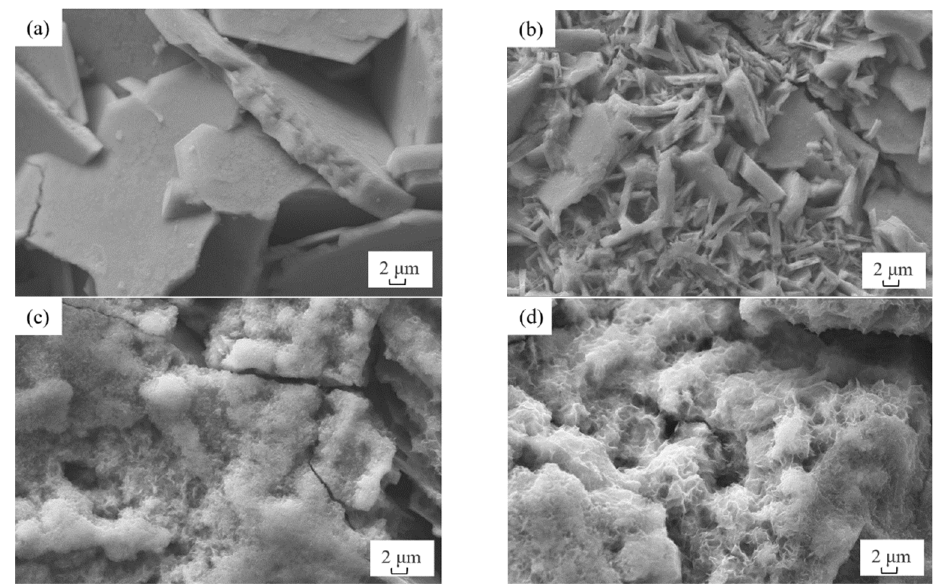
Figure 11. SEM high magnification corrosion product morphology, ( a , b ) prismatic corrosion products; ( c , d ) spherical corrosion products.